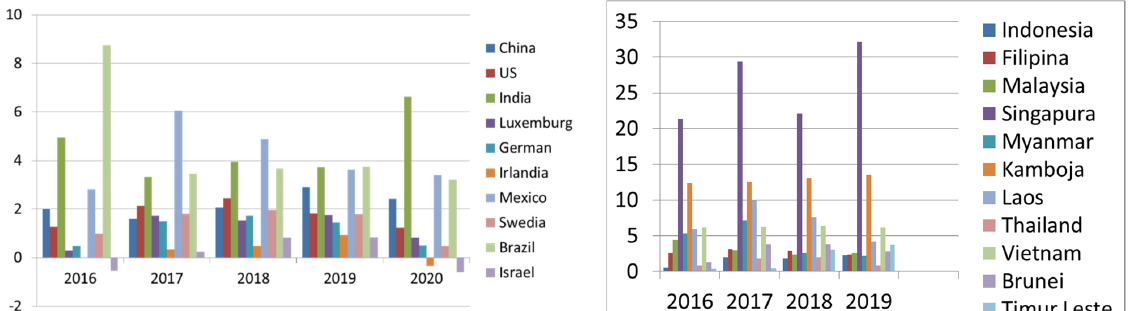
Fig. 3. Inflation/consumer price index for 10 countries Fig. 4. Foreign direct investment net inflow